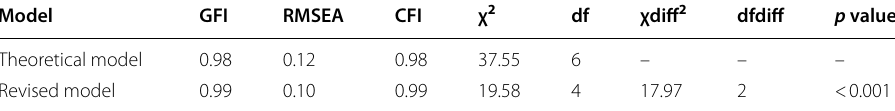
Table 4 Comparison of theoretical and revised models using chi square difference test Model GFI RMSEA CFI χ 2 df χdiff 2 dfdiff p value Theoretical model 0.98 – – Revised